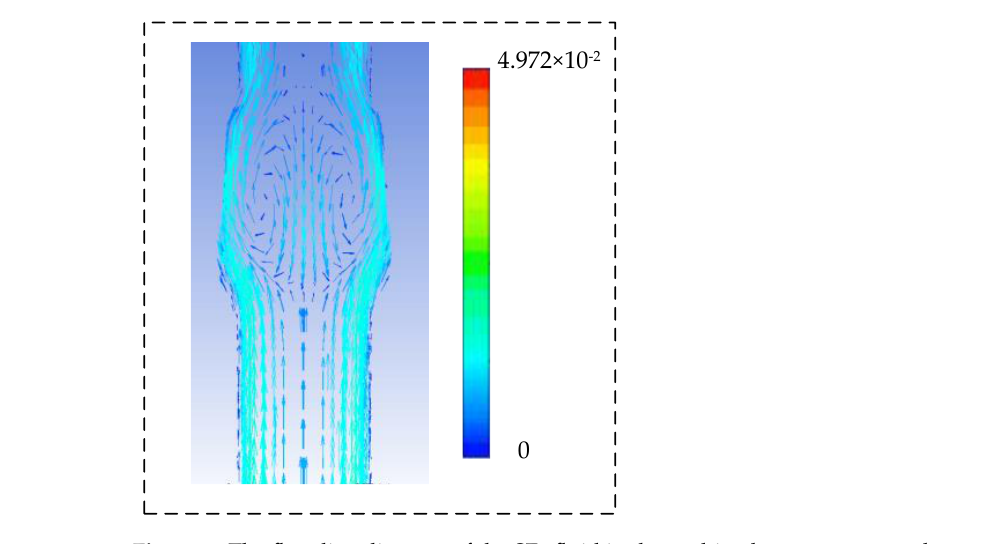
Figure 6. The flow line diagram of the SF 6 fluid in the multi-column arrester under monopole metal loop operation mode.